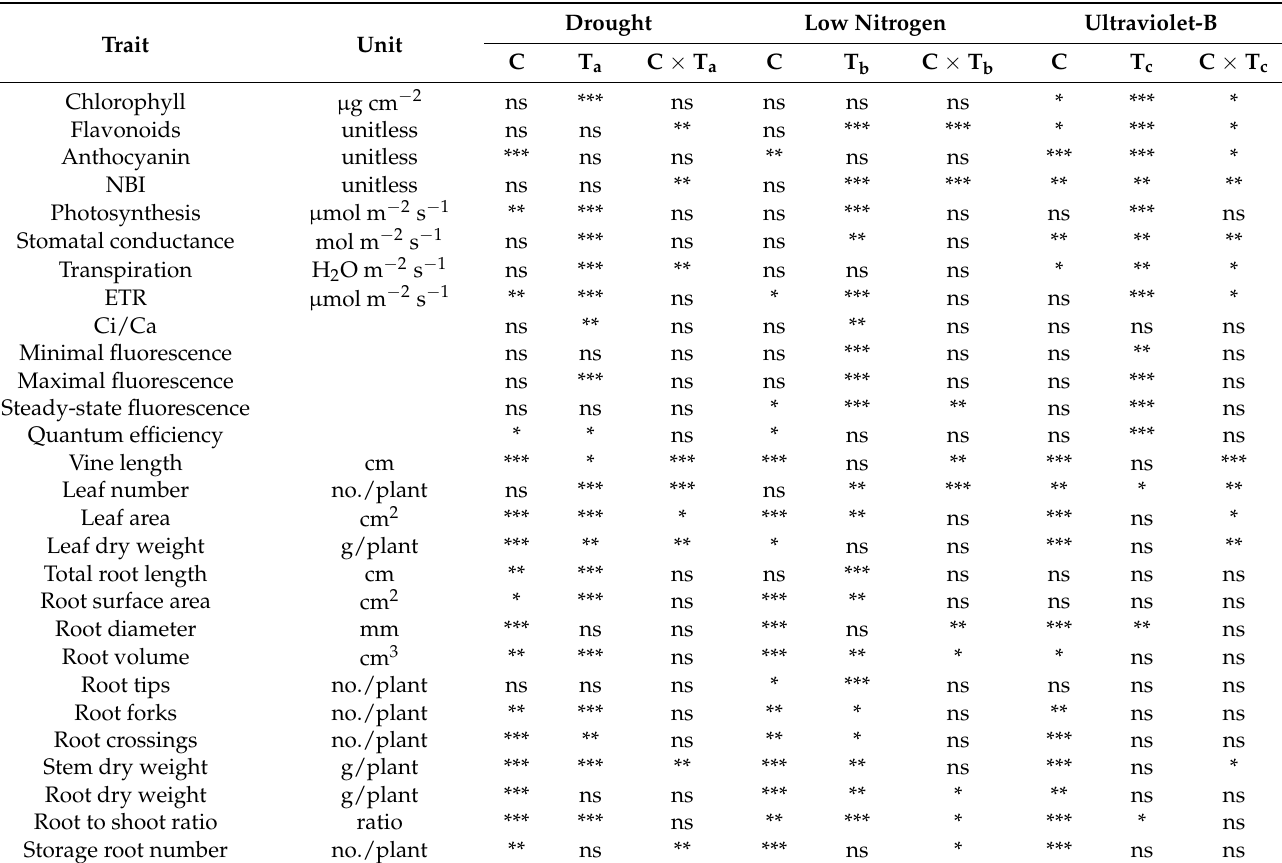
Table 1. Analysis of variance of the cultivar (C), treatment (T), and their interactions (C × T) for physiological, and shoot- and root-related traits of 10 cultivars of sweetpotato measured at 20 days after